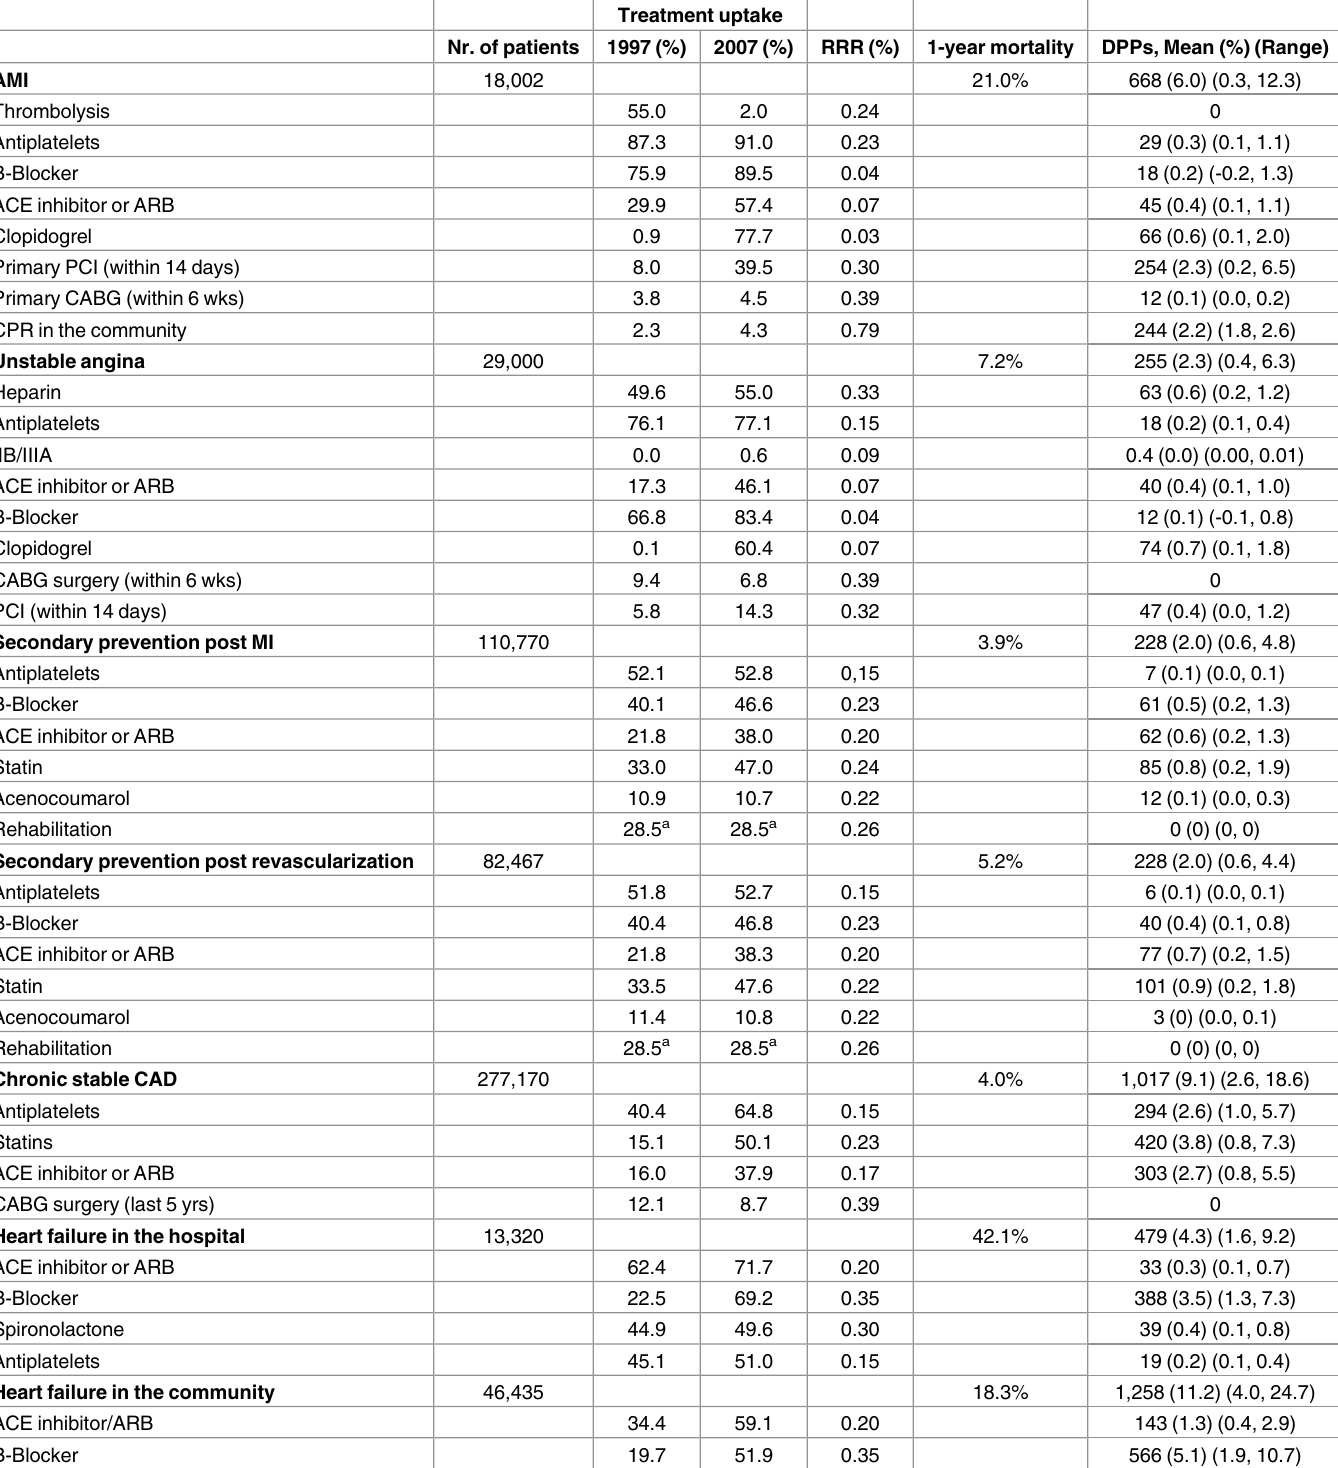
Table 1. Deaths Prevented or Postponed (DPPs) due to change in acute-phase and secondary prevention treatments for CHD between 1997 and